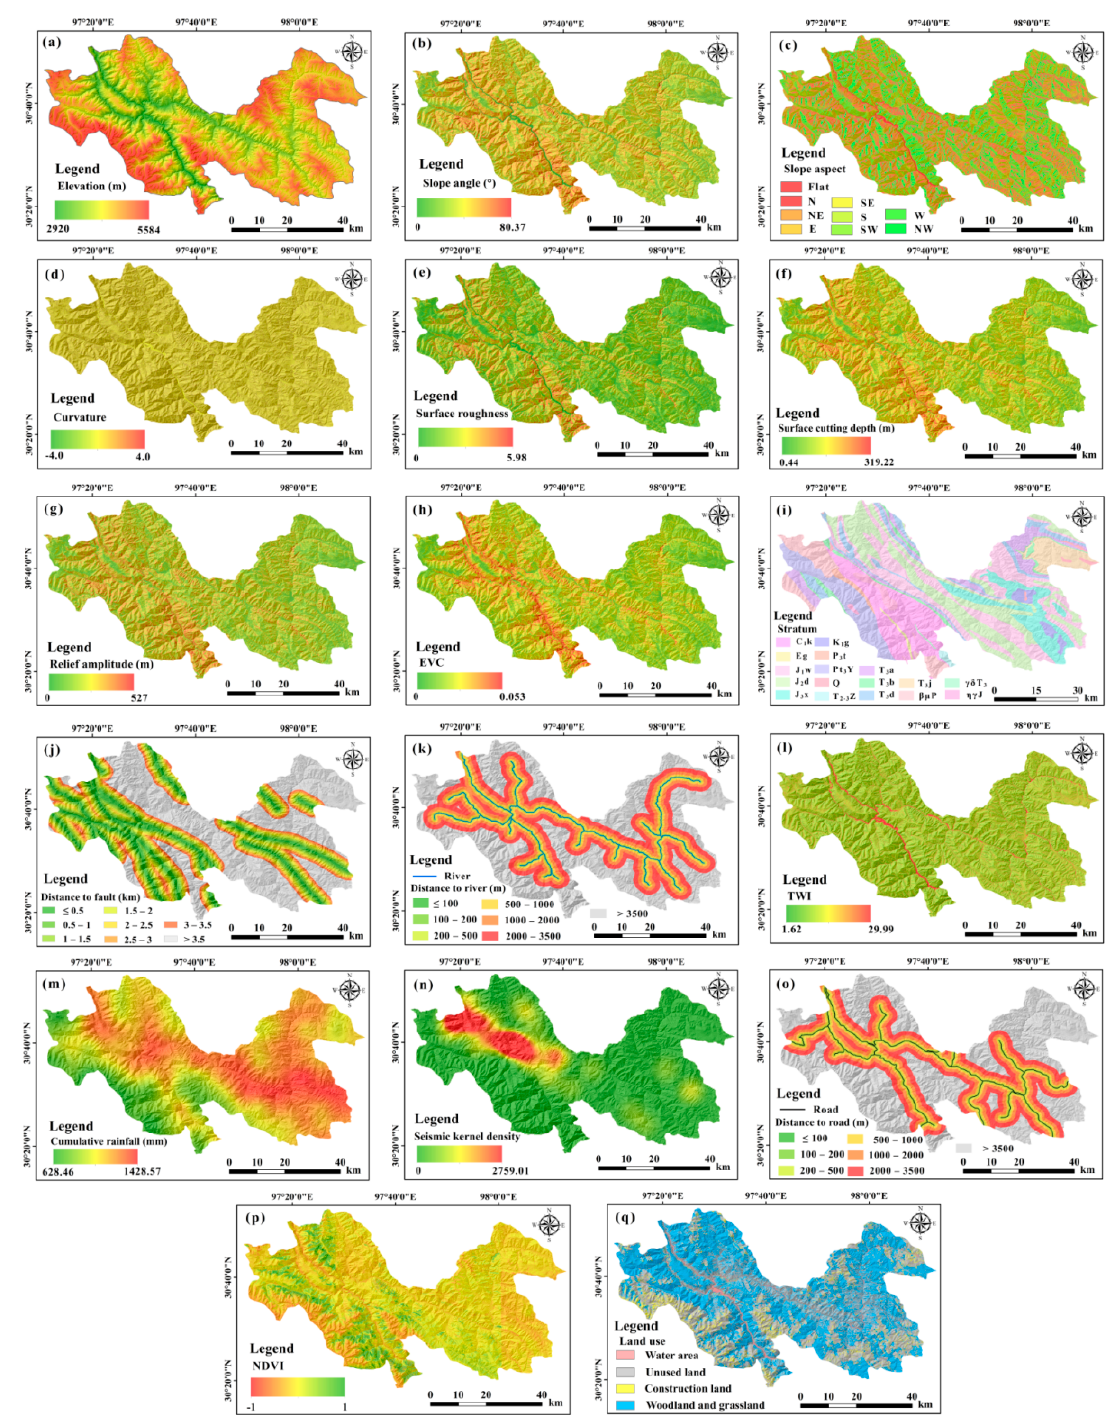
Figure 7. Initial indices of landslide susceptibility assessment constructed from multisource data. ( a ) Elevation. ( b ) Slope angle. ( c ) Slope aspect. ( d ) Curvature. ( e ) Surface roughness. ( f ) Surface cutting depth. ( g ) Relief amplitude. ( h ) Elevation variation coefficient (EVC). ( i ) Stratum. ( j ) Distance to fault. ( k ) Distance to river. ( l ) Topographic wetness index. ( m ) Cumulative rainfall. ( n ) Seismic kernel density. ( o ) Distance to road. ( p ) Normalized difference vegetation index. ( q ) Land use. Table 3. Landslide susceptibility statistics.